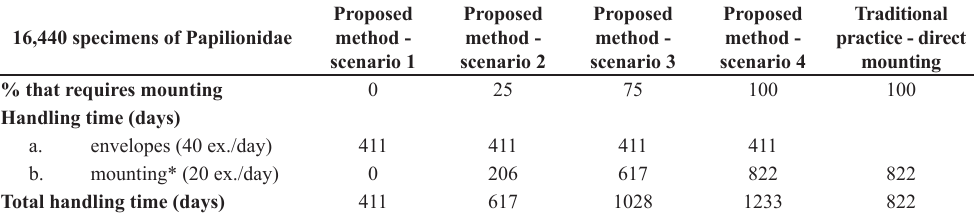
Table 1. Time required to handle and digitize 16,440 specimens of Papilionidae in four scenarios, compared to the traditional practice of direct mounting. Scenario 1 corresponds with the results of the 2016 pilot. 16,440 specimens of Papilionidae